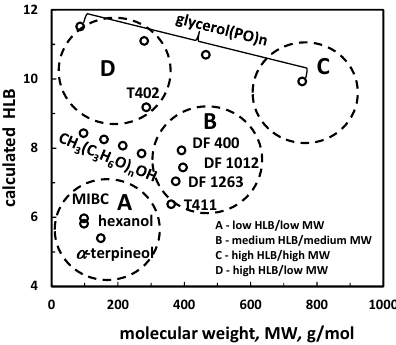
Figure 1. Two-numerical value classification of frothers in pure state according to hydrophobic-lipophilic balance (HLB) and molecular weight (MW) (based on [16]).